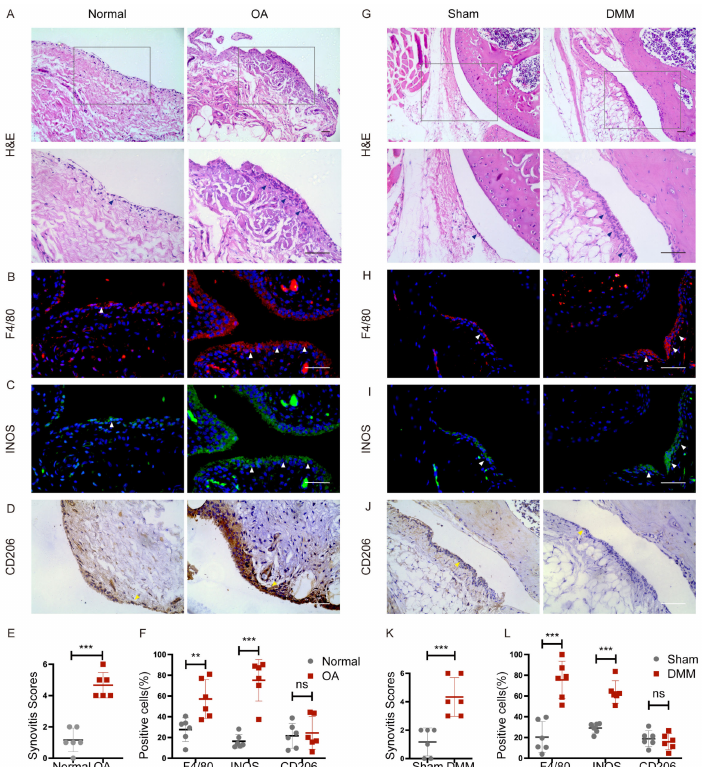
Figure 1. Macrophage polarization in synovium from patients with OA and DMM mice. Normal controls and OA human synovium were stained with ( A ) hematoxylin-eosin staining (H&E), im- munofluorescence of ( B ) F4/80, ( C ) INOS, and immunohistochemistry of ( D ) CD206. The boxed area is enlarged in the picture below. Blue arrows showed synovial hyperplasia. White arrows indicate F4/80 and INOS-positive cells. Yellow arrows indicate CD206-positive cells. Scale bars: 50 µ m. ( E ) Synovitis score quantification in normal ( n = 6) and osteoarthritic ( n = 6) human synovium. *** p < 0.001. ( F ) Quantification of the percentages of F4/80, INOS, and CD206-positive macrophages in normal and OA human synovium. ** p < 0.01, *** p < 0.001. Representative images of ( G ) H&E staining, immunofluorescence of ( H ) F4/80, and ( I ) INOS, immunohistochemistry of ( J ) CD206 in the synovium of Sham and DMM mice 2 months after surgery. Blue arrows showed synovial hyperplasia. White arrows indicate F4/80 and INOS-positive cells. Yellow arrows indicate CD206-positive cells. Scale bar: 50 µ m. ( K ) Synovitis score quantification in Sham ( n = 6) and DMM ( n = 6) mice synovium. *** p < 0.001. ( L ) Quantification of the percentage of F4/80, INOS, and CD206-positive macrophages in Sham and DMM mice synovium. *** p < 0.01. F4/80: red; INOS: green; Nuclear: